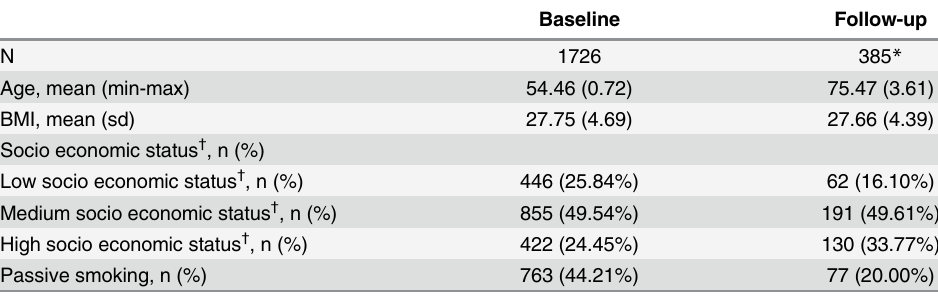
Table 1. Description of the study characteristics of the healthy never-smoking women (HNSW) at baseline and follow-up examination.